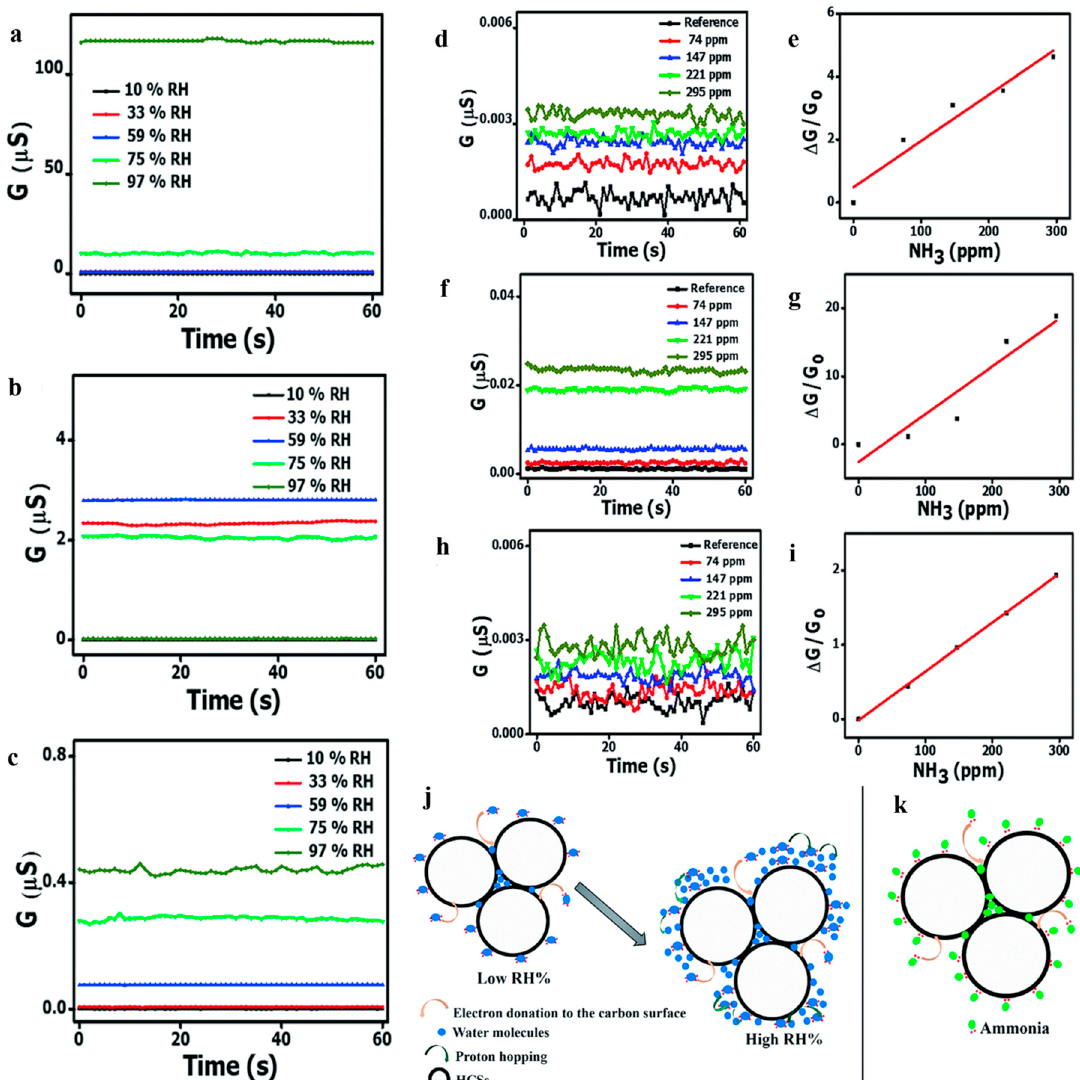
Figure 23. RH-dependent conductivity curves of ( a ) pure HCS, ( b ) HCS/PVP composite, and ( c ) annealed HCS based sensors at 40 °C. Ammonia concentration-dependent conductance and sensitivity of ( d , e ) pristine HCS, ( f , g ) HCS/PVP, and ( h , i ) annealed HCS based sensors at 10% RH at 40 °C. A schematic illustration of the sensing mechanism to NH 3 of the HCSs at low RH ( j ) and high RH ( k ). Reproduced with permission from [114]. Copyright Royal Society of Chemistry, 2017.